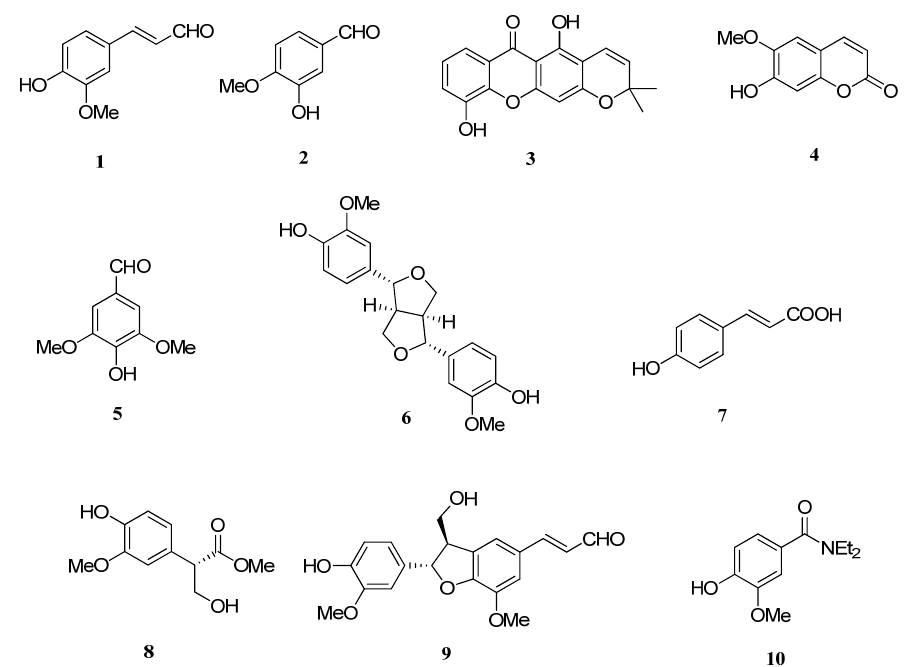
Figure 2. Structures of compounds 1–10